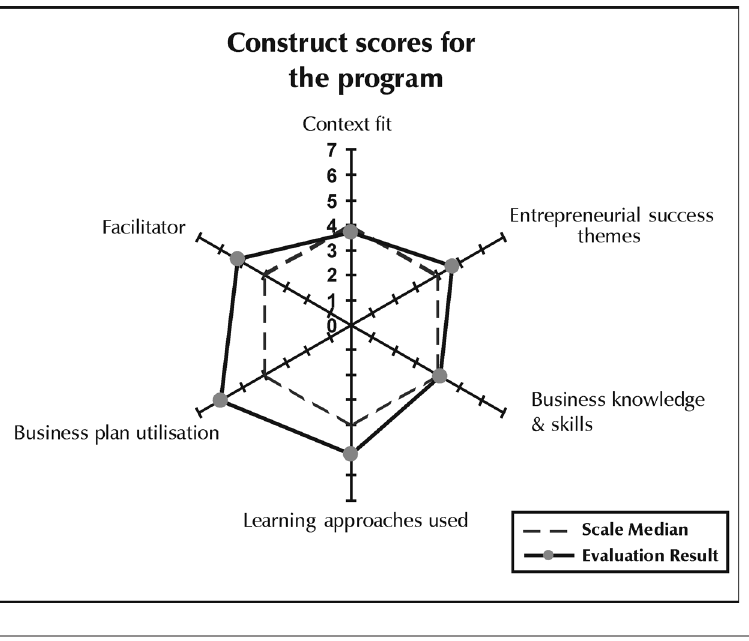
Graphical representation of evaluation results for the overall NVC learnership programme of the NVCL compared to the